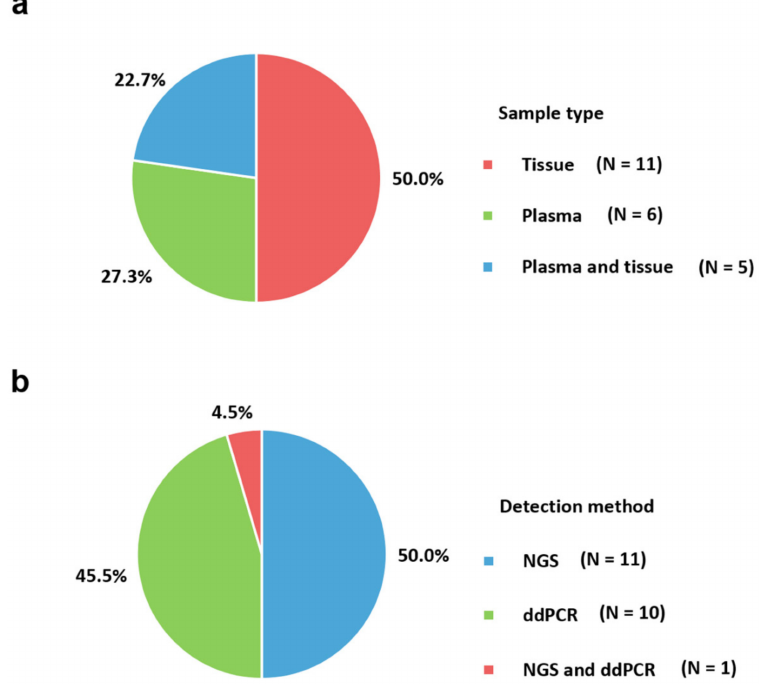
Figure 1. Applied laboratory assays for identifying ESR1 mutations. ( a ) Pie charts showing the sample types used; ( b ) Pie charts showing the use of molecular detection methods. NGS, next-generation sequencing; ddPCR, droplet digital polymerase chain reaction.